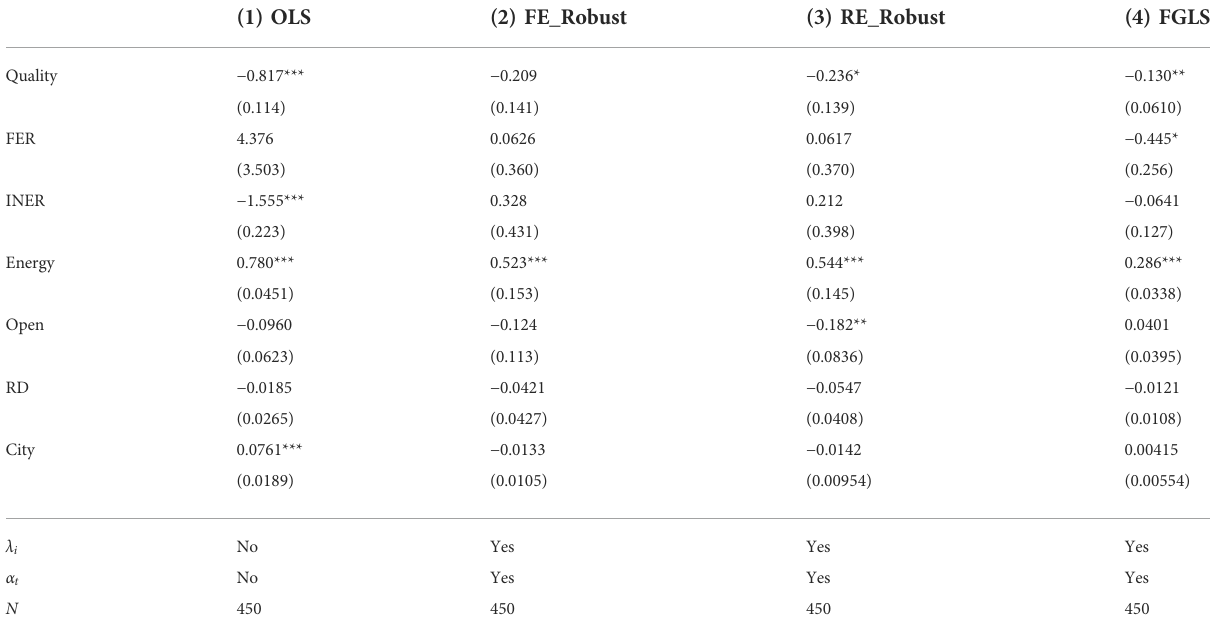
TABLE 1 Estimation results of model 16.